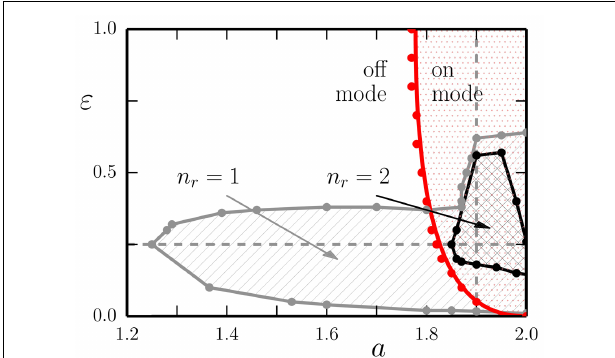
FIGURE 3 | The phase diagram of the one-rod barrel, as a function of the gain a and of the adaption rate " . The results are obtained using the LPZRobots package, apart from the red solid line separating the off- and the on-mode, which follows from equation (5), for a fixed but otherwise arbitrary angle ϕ = ϕ 0 . The dashed vertical and horizontal gray lines indicate the cuts used for the phase diagrams presented in Figure 5 . The number of stable limit cycles found in the respective parameter regions is denoted by n r . Non-rolling modes: the red dots/lines indicate the locus of a Hopf bifurcation, where a stable non-rolling limit cycle (on mode) emerges from the trivial non-rolling fixpoint (off mode). In the off mode the “engine” db ( t )/ dt , see equation (1), kicks in only when the barrel is already moving. Rolling modes: shown are the regions containing n r = 1 (enclosed by the solid gray line) and n r = 2 (enclosed by the solid black line) attracting limit-cycles corresponding to a barrel moving with a finite velocity < v b > . Note that the robot is able to move also in the off mode (of the engine). The stationary and the drifting back-and-forth modes, discussed in Figure 6 , have been omitted, in order to avoid